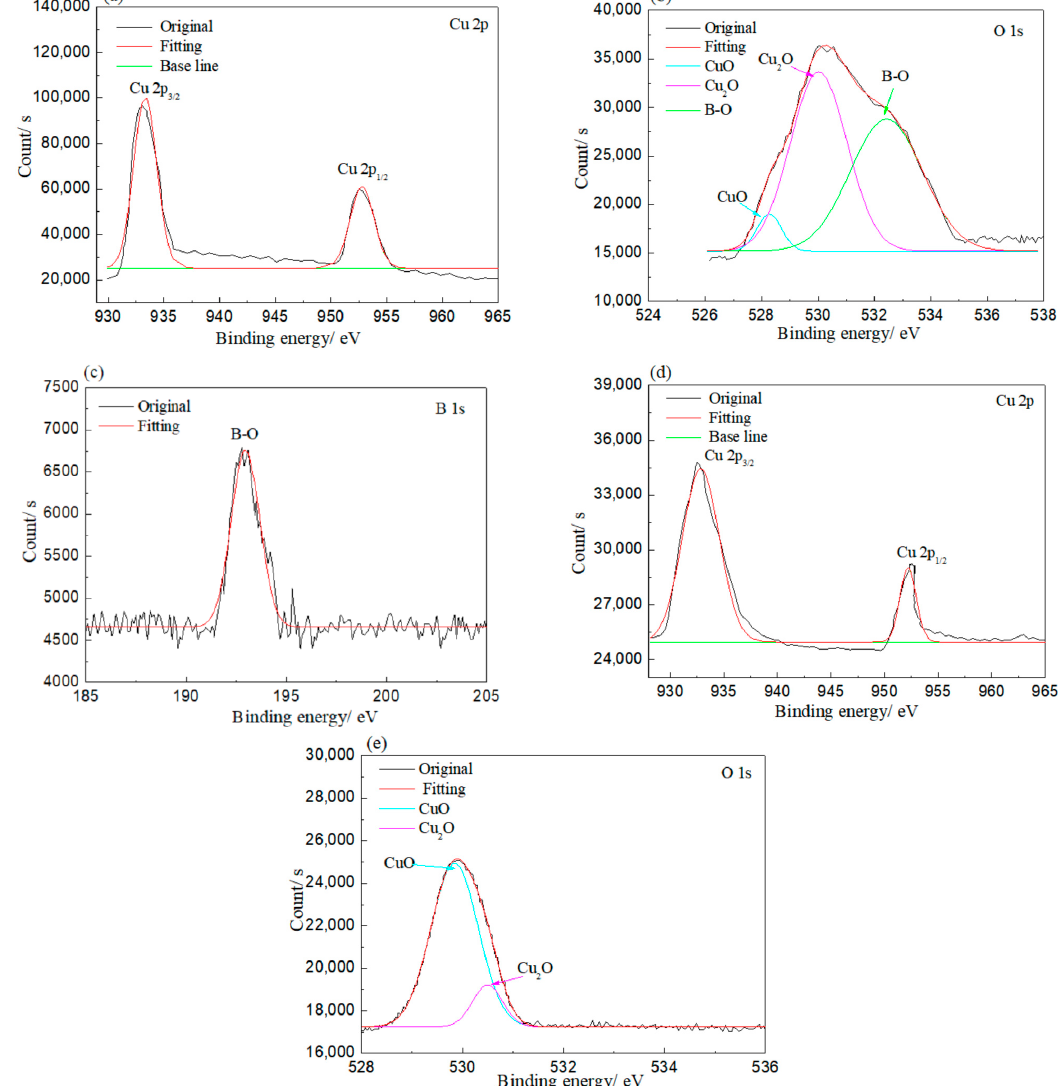
Figure 5. XPS results of rolled copper foil corroded in condition E ( a – c ); and condition A ( d , e ).